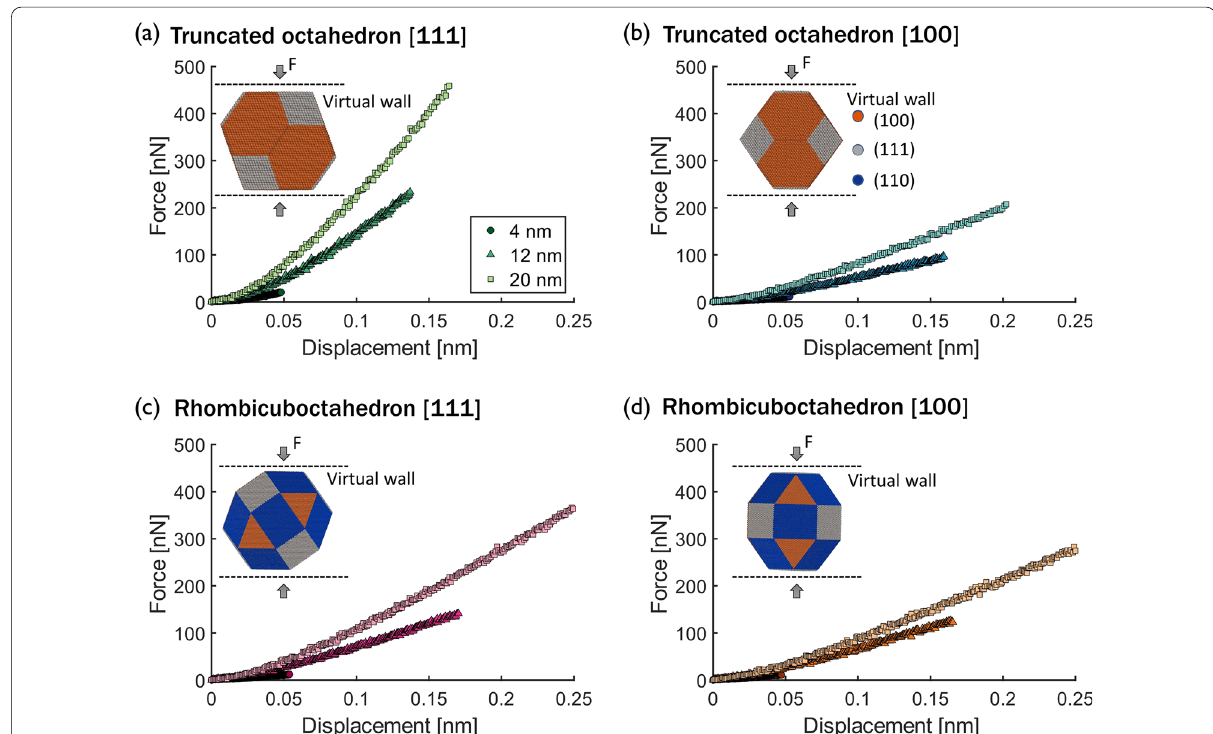
Fig. 1 Nanoparticle models and force-vs-displacement compression response. Force vs displacement of nanoparticles with two different shapes, a , b truncated octahedron and c , d rhombicuboctahedron. The nanoparticles were tested in two crystallographic orientations with respect to the direction of the load, a , c corresponding to the {111} orientation and b , d to the {100} orientation. Insets are snapshots of the models with atom color corresponding to the {100}, {111}, and {110}